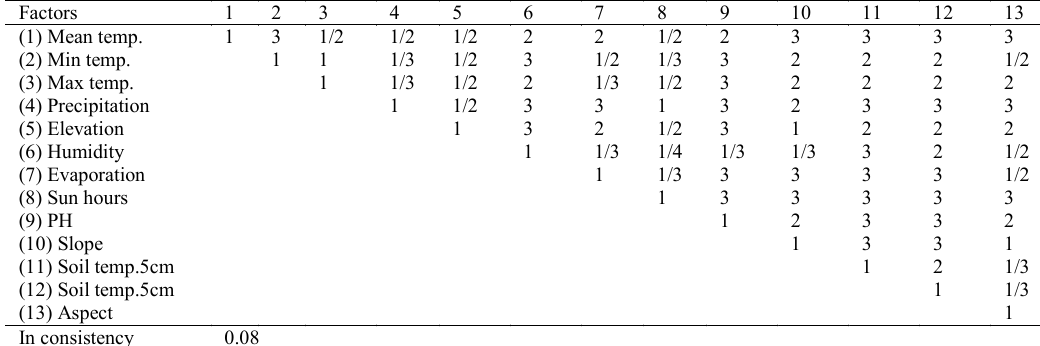
Table 2: Pairwise comparison matrix for dataset layers of susceptibility areas analysis resulted from questionnaire Factors